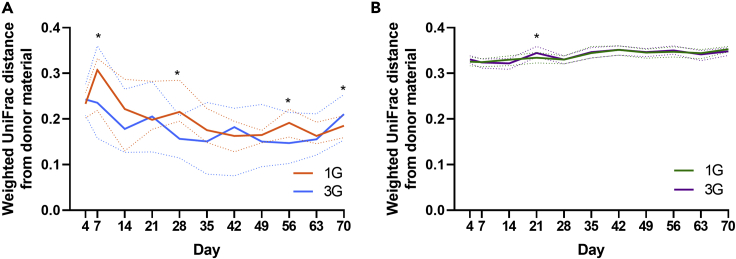
Compositional similarity of the donor microbiota and recipient microbiotaWeighted UniFrac distance between the microbiota of recipient mice that received (A) native microbiota or (B) microbiota derived from antibiotic-disrupted mice, and their respective donor microbiota throughout the 70-day study period. Recipient mice received either one round (1G) or three rounds (3G) of donor microbiota. The solid and dotted lines denote the median and interquartile ranges, respectively. Statistical comparison between the 1G and 3G groups at each time point was performed using the Mann-Whitney test (p < 0.05).